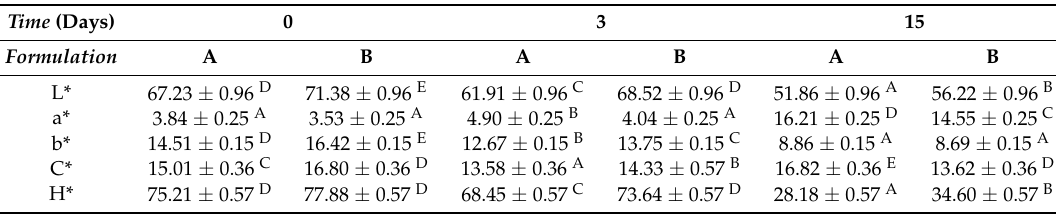
Table 2. Analysis of the color parameters of spontaneously fermented sausages made with two different formulations.